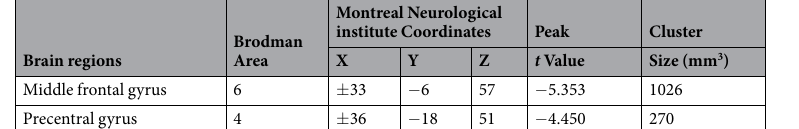
Table 2. The areas of VMHC differences between patients with RBD and HC. VMHC = voxel-mirrored homotopic connectivity. RBD = remitted bipolar disorder. HC = healthy